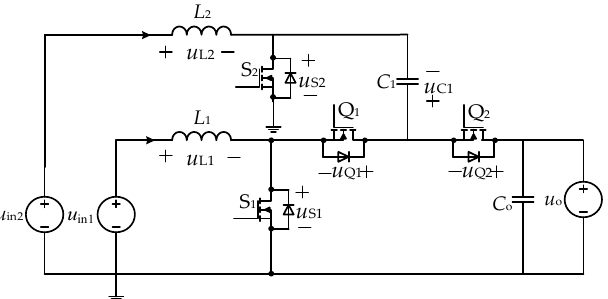
Figure 2. A multi-input-port bidirectional DC/DC converter for energy storage systems in a DC microgrid.